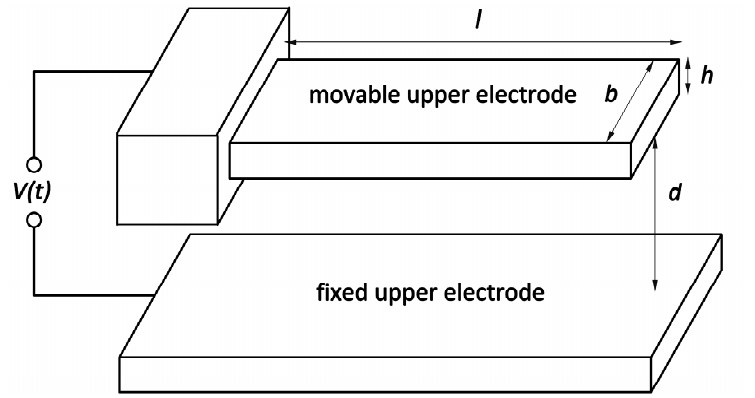
Figure 4. Simulation model of electrostatic MEMS cantilever.